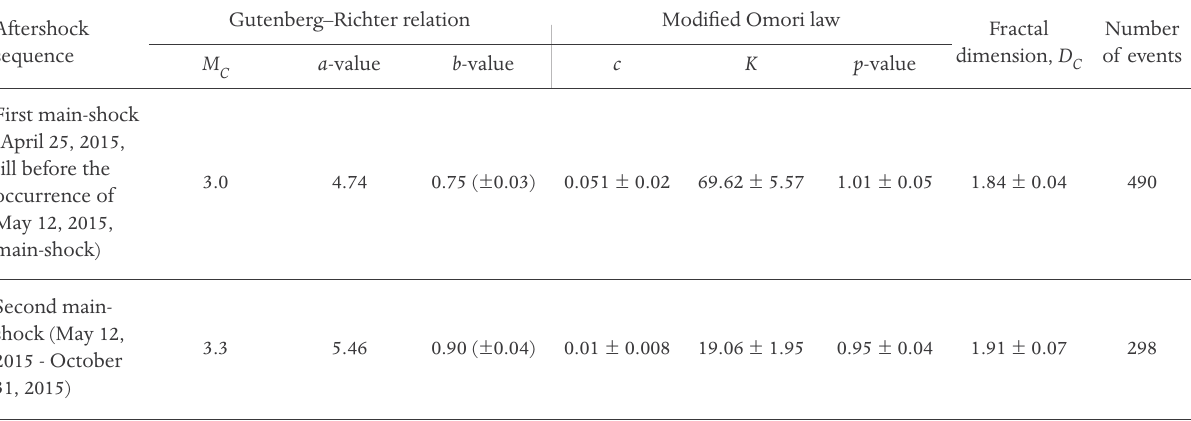
Table 3. Summary of the results estimated from the established statistical